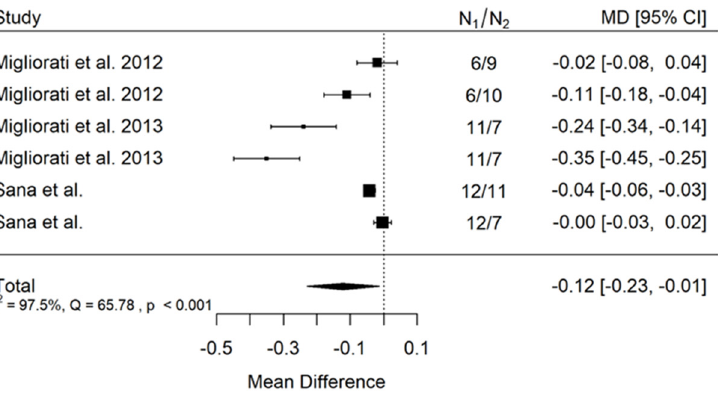
Figure 10. Forest plot for evalutaion of thread shape factor infulence on pull-out strentght in artifical bone model studies [33,34,41].